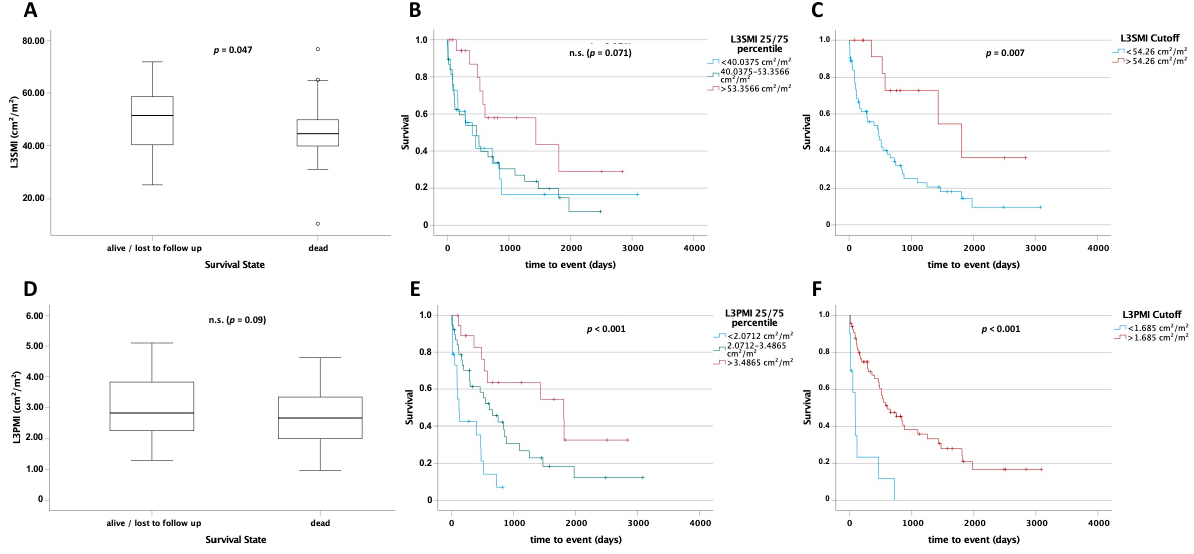
Figure 4. L3SMI and L3PMI are predictors for postoperative survival. L3SMI ( A ) and L3PMI ( D ) levels in survivors were higher than those in deceased patients. Patients with an L3SMI ( B ) or L3PMI ( E ) above the 75th percentile had a significantly higher overall survival. Using an optimal cut-off of 54.26 cm 2 /m 2 for L3SMI ( C ) and 1.685 cm 2 /m 2 for L3PMI ( F ), patients above these values had a significantly higher overall survival. ° = outlier; n.s. = not significant.